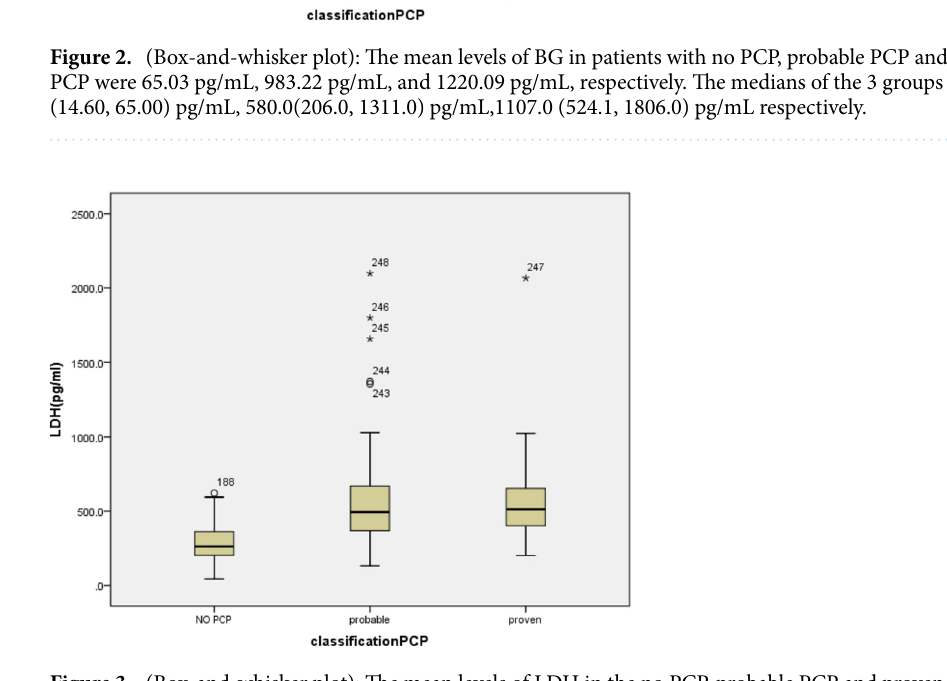
Figure 3. (Box-and-whisker plot): The mean levels of LDH in the no PCP, probable PCP and proven PCP groups were 297.62 U/L, 547.88 U/L, and 854.23 U/L. The medians of the 3 groups were 263.0 (203.0, 302.0) pg/ mL, 494.0 (367.0, 672.0) pg/mL, 512.0 (401.0, 653.0) pg/mL